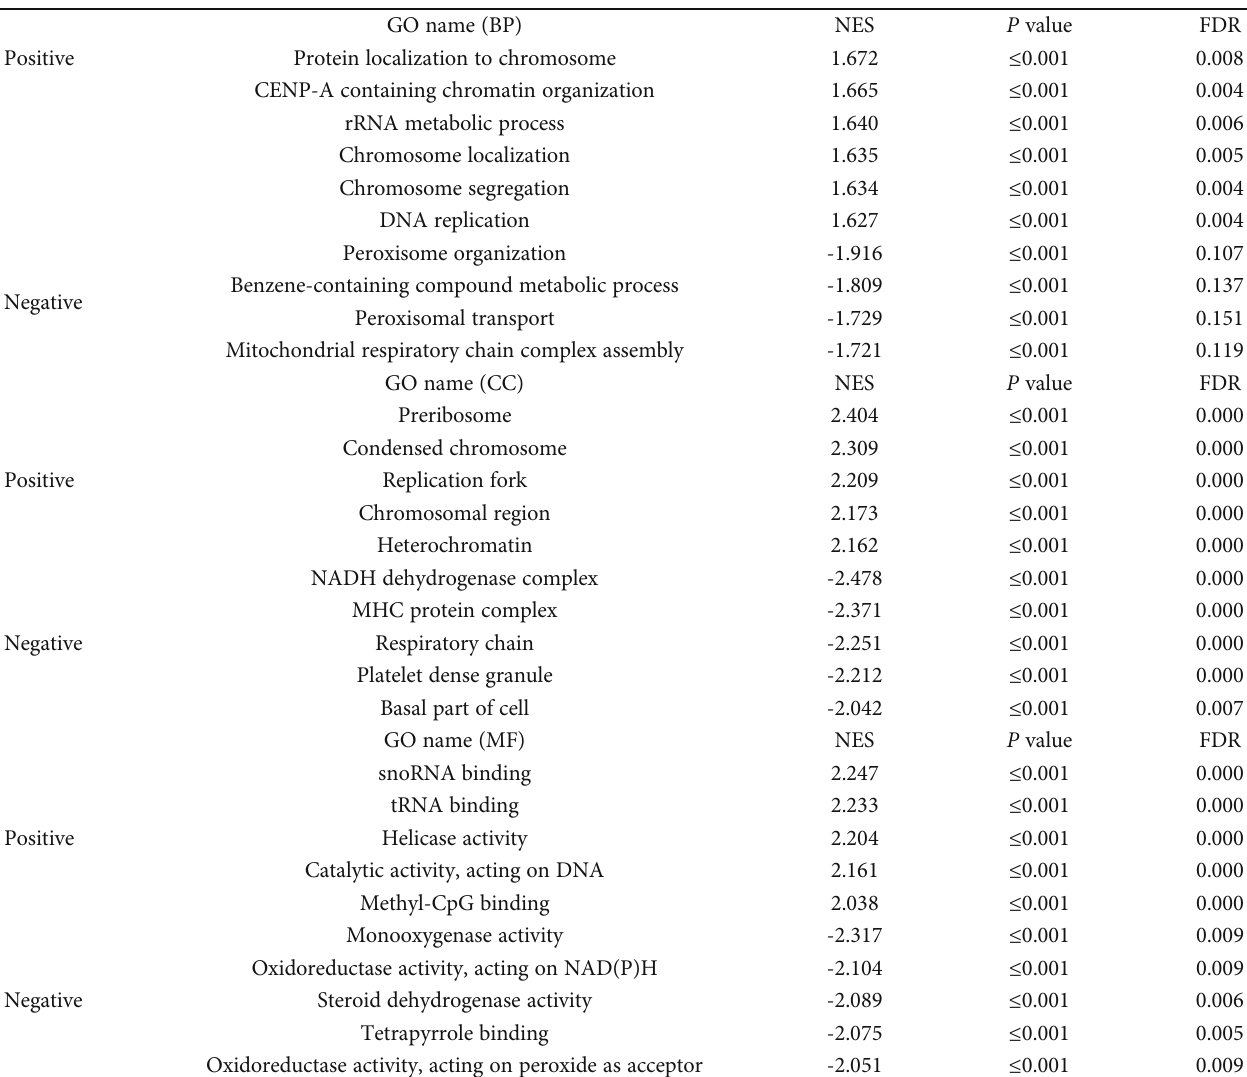
Table 1: Signaling pathways most signi fi cantly correlated with DHX37 expression based on their normalized enrichment score (NES) and P